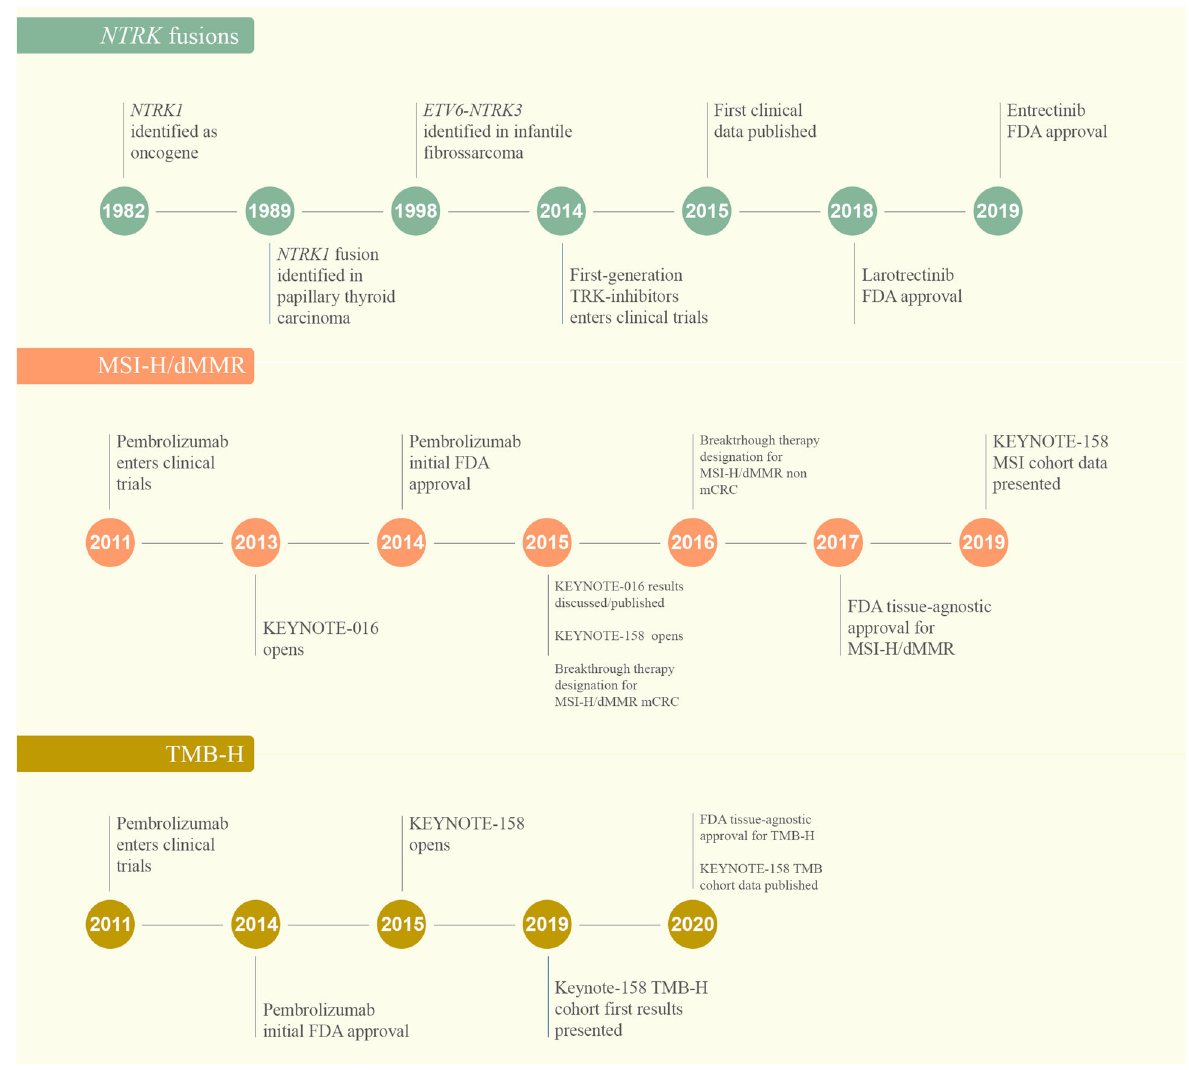
Fig. 1 Timeline of discovery, validation, and clinical development of tissue-agnostic therapies. dMMR: mismatch repair de fi ciency, FDA: The United States Food and Drug Administration agency; MSI-H: microssatellite instability high, mCCR: metastatic colorectal cancer, TMB-H: tumor mutational burden high (cut-off ≥ 10